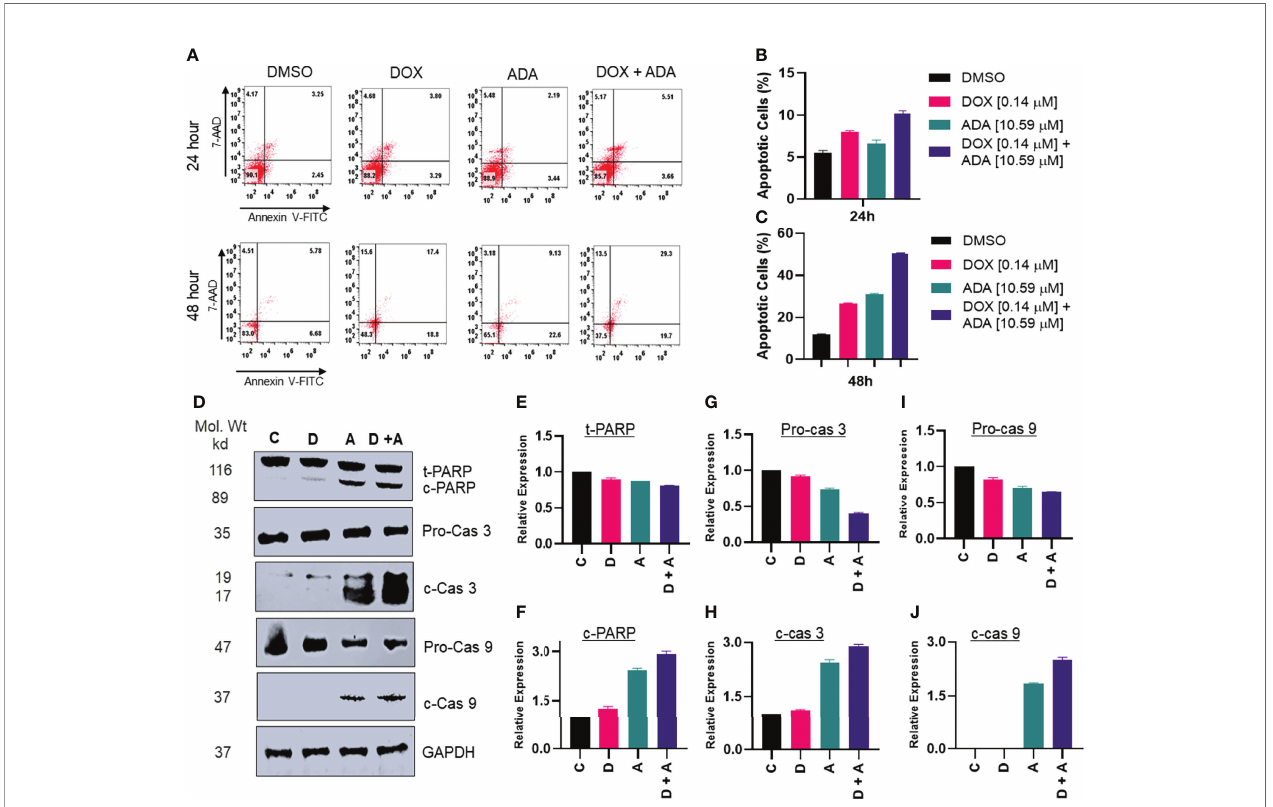
FIGURE 6 | Adapalene and doxorubicin, in a synergistic manner, promote apoptosis. (A – C) Annexin V & &-AAD staining showed high apoptotic cells in plates treated with the combination of DOX or ADA or both after 24h or 48hr periods. (D) Western blots of expression levels of PARP, c-PARP, pro-caspase 3, c-caspase 3, pro- caspase 9 and c-caspase 9 on MDA-MB-231 with DOX/ADA or both for 24 hrs. Co-treatment showed enhanced PARP cleavage and activation of caspase 3 and caspase 9. C , control (Treated with drug vehicle); D, doxorubicin; A, adapalene; A + D, adapalene + doxorubicin (E – J) Relative expression plots of western